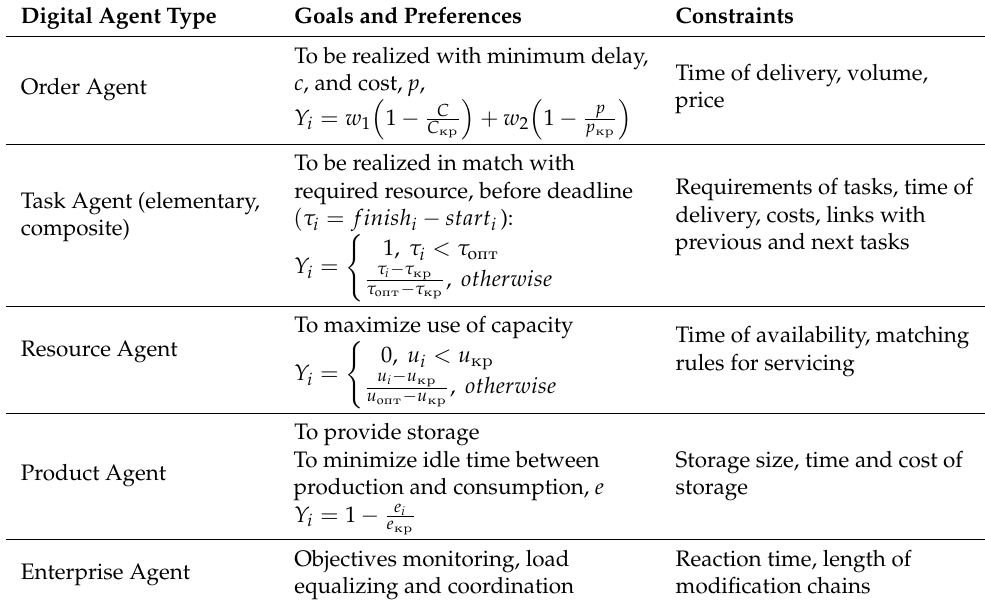
Table 5. Main classes of